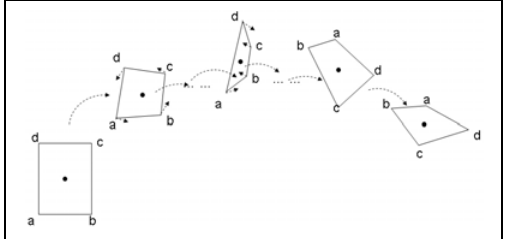
Figure 2. Direct interpolation cases intermediate images to be flipped, and collapsed onto a line or even a point when a large rotation